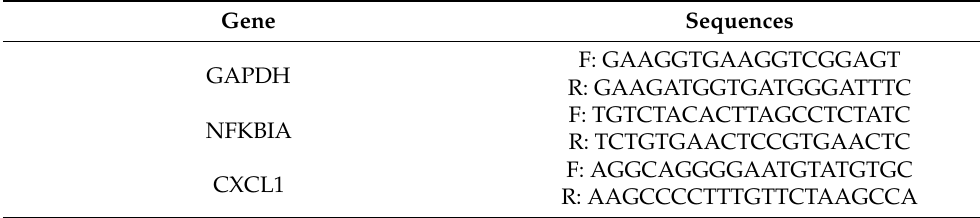
Table 1. Primer sequences used for